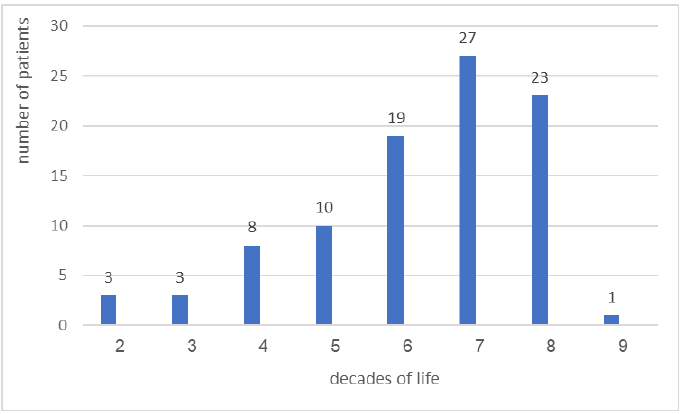
Figure 1. Distribution of patients with lesions containing embedded CH according to decades of